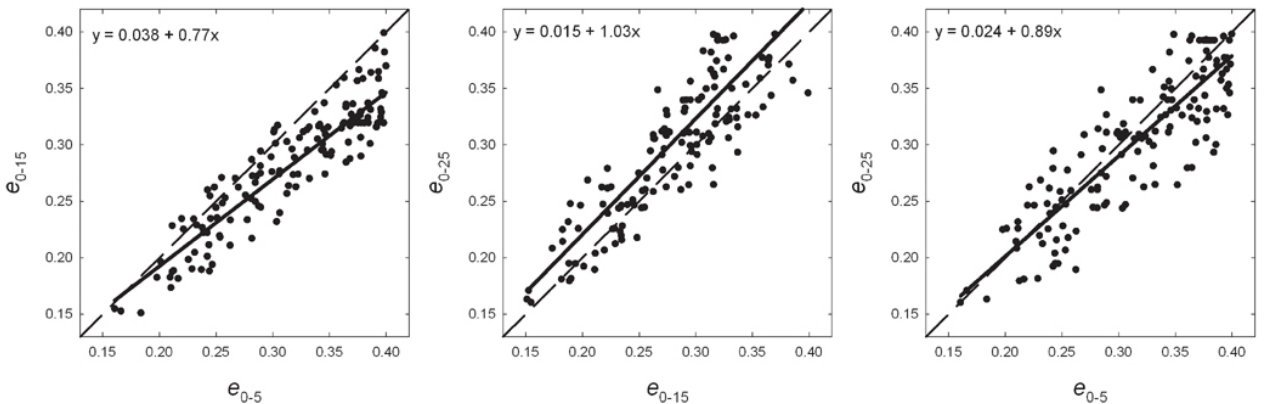
Fig. 5. Correlations between efficiencies at 5 ◦ C, 15 ◦ C, and 25 ◦ C from behavioural parameter sets in the one initial quality, flexible decomposer efficiency model. Solid line: linear regression of data. Broken line: 1:1 line.